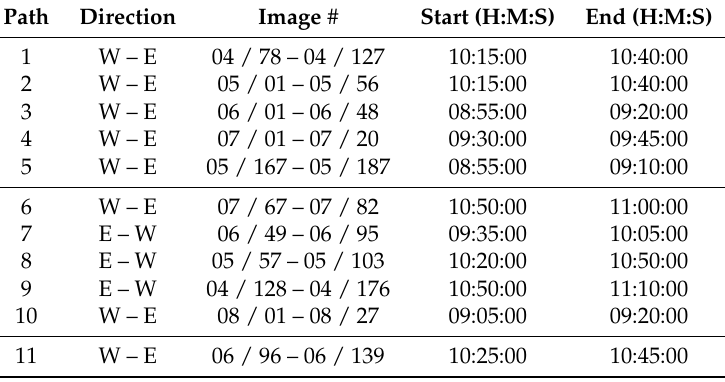
Table A1. Flight path meta-data for the Isangi-Stanleyville aerial survey. Data provided consists of the flight path number, cardinal direction of the flight, the image numbers, and the duration of the flight provided by the start and end time of the acquisition. Data is sourced from Appendix A Figure A2 and the sensor logs recorded in the margin of acquired images (see Figure 1 main